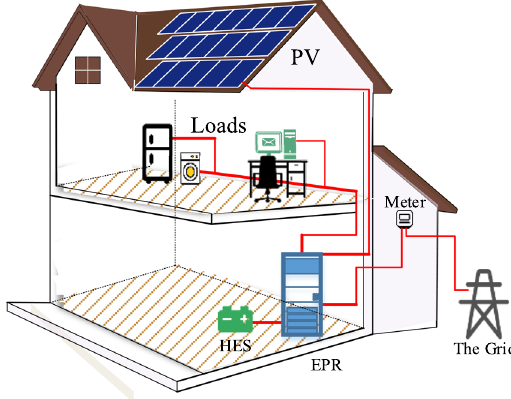
Fig. 2 Application scenarios of a household-level electric power router